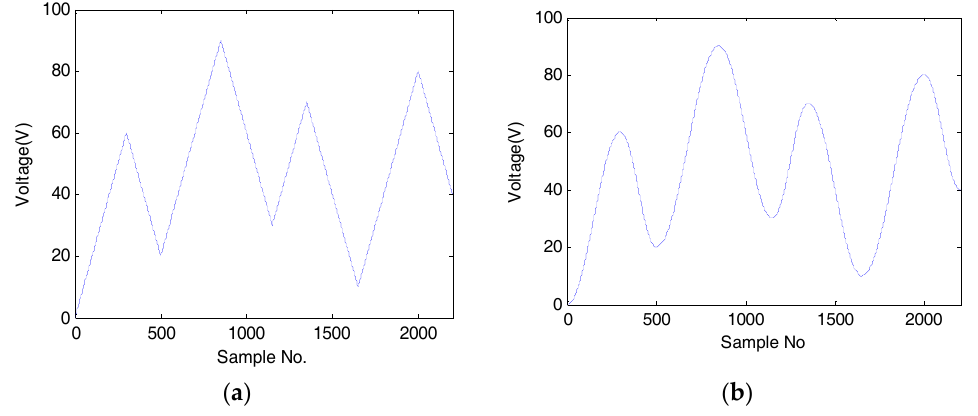
Figure 17. The input excitations. ( a ) Triangular signals; ( b ) sinusoidal signals.